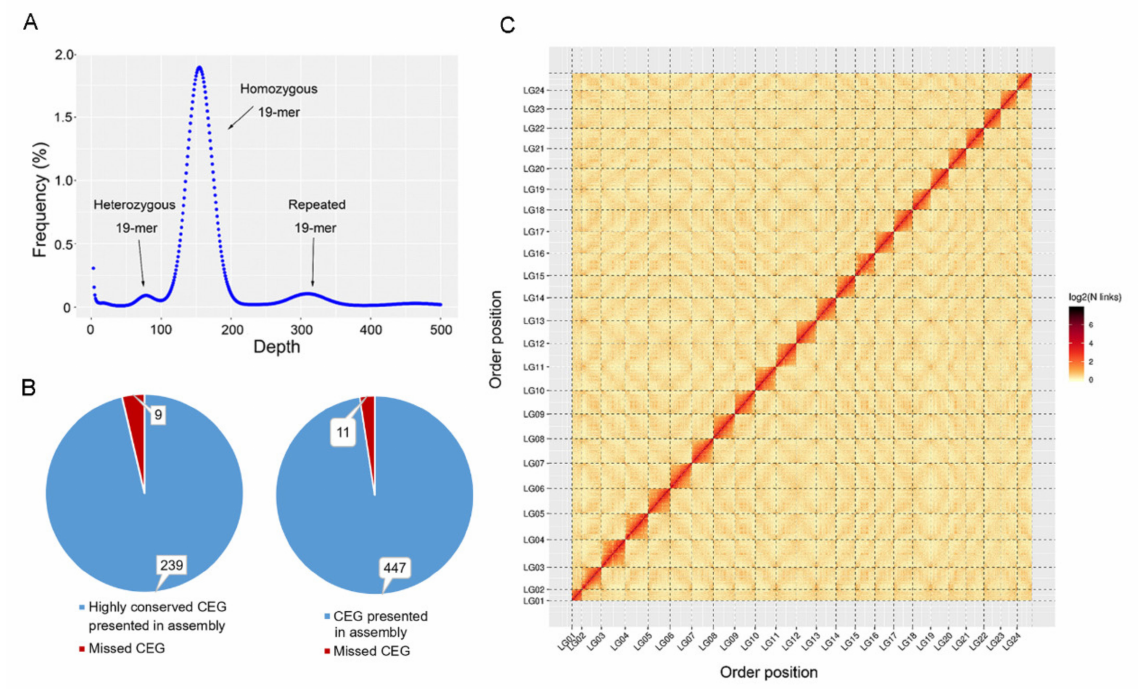
Figure 2. Genome assembly of humpback grouper. ( A ) Estimation of genome size, repeat content and heterozygous by survey using 19-mers in humpback grouper; ( B ) Verification of genome integrality based on the Core Eukaryotic Genes Mapping Approach (CEGMA) database; red parts and blue parts indicated missed and presented core eukaryotic genes (CEG) in humpback grouper genome, respectively; ( C ) The genome contig contact matrix; the blocks indicated the contacts between linkage groups; color depth indicated the degree of